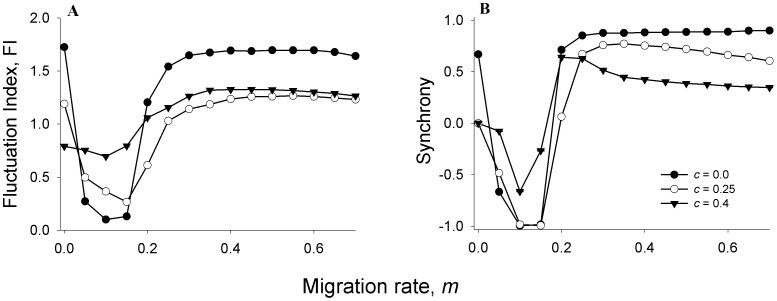
Effects of ALC on metapopulation FI and synchrony at different rates of migration.(A). Both LALC (c = 0.25) and HALC (c = 0.4) increases metapopulation FI at low migration rates, but reduces the same at high migration rates. This contrasting effect can be explained by (B) which shows that ALC reduces both positive and negative synchrony, which in turn is expected to have opposite effects on metapopulation constancy. N0 = 20 and K = 30 for all figures including this one. Intrinsic growth rate, r = 3.5 (for this and all subsequent figures except Figure 2). Each point in every figure is a mean of 100 independent runs. Error bars denote ±SEM and are too small to be visible.